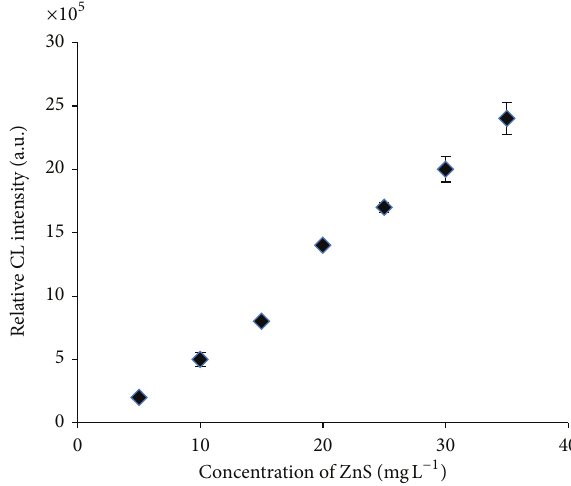
Figure 10: Effect of ZnS QDs concentration on the CL system in phosphate buffer (0.1M, pH 8.0), H 2 O 2 , 0.5M. The CL intensity was obtained from the average of three